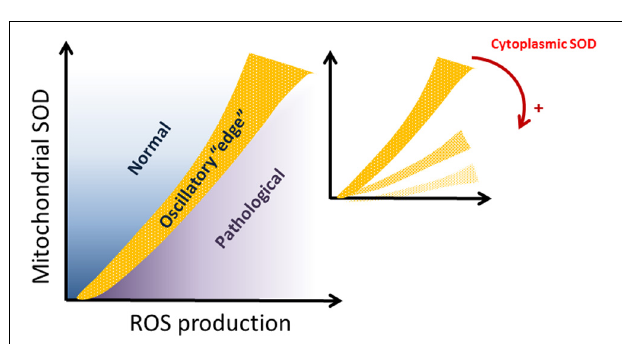
H 2 O 2i , (cid:2)(cid:3) m and succinate for MnSOD (A) 10.2, (B) 17, and (C) ∼ 21.7 µ M. The attractors described in the 3D phase plots correspond to the same time series shown Figures 5A,D,E .